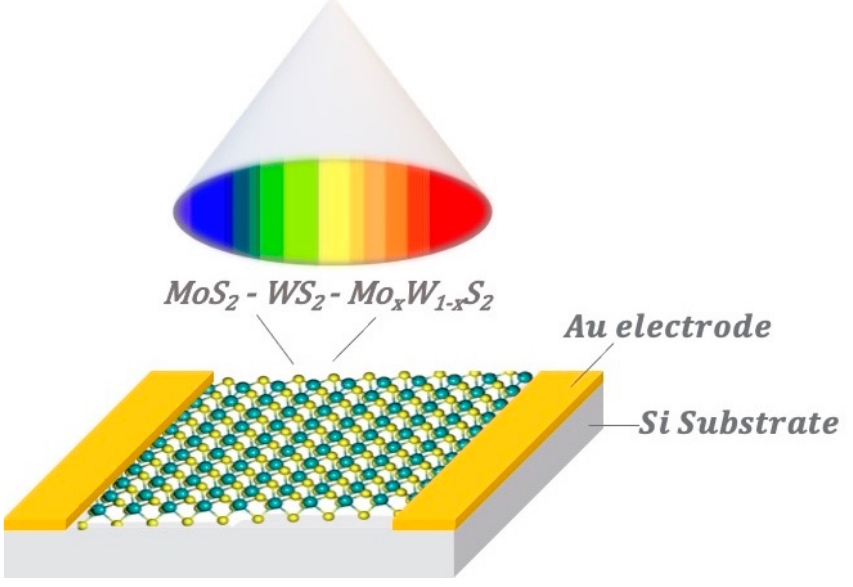
Figure 9. Schematic of the photoresponse measurements set up used for all samples.